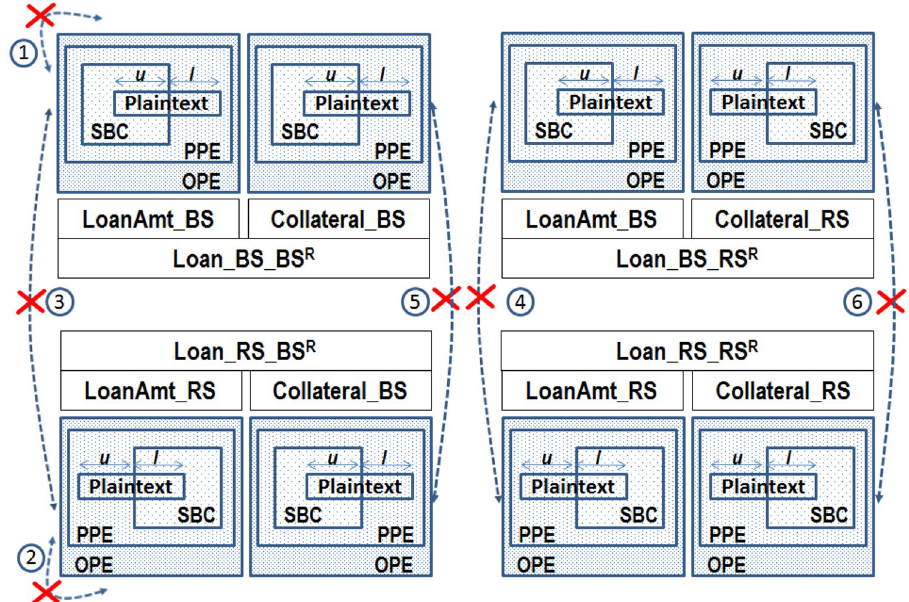
Fig. 7 Ensuring security of LoanAmt